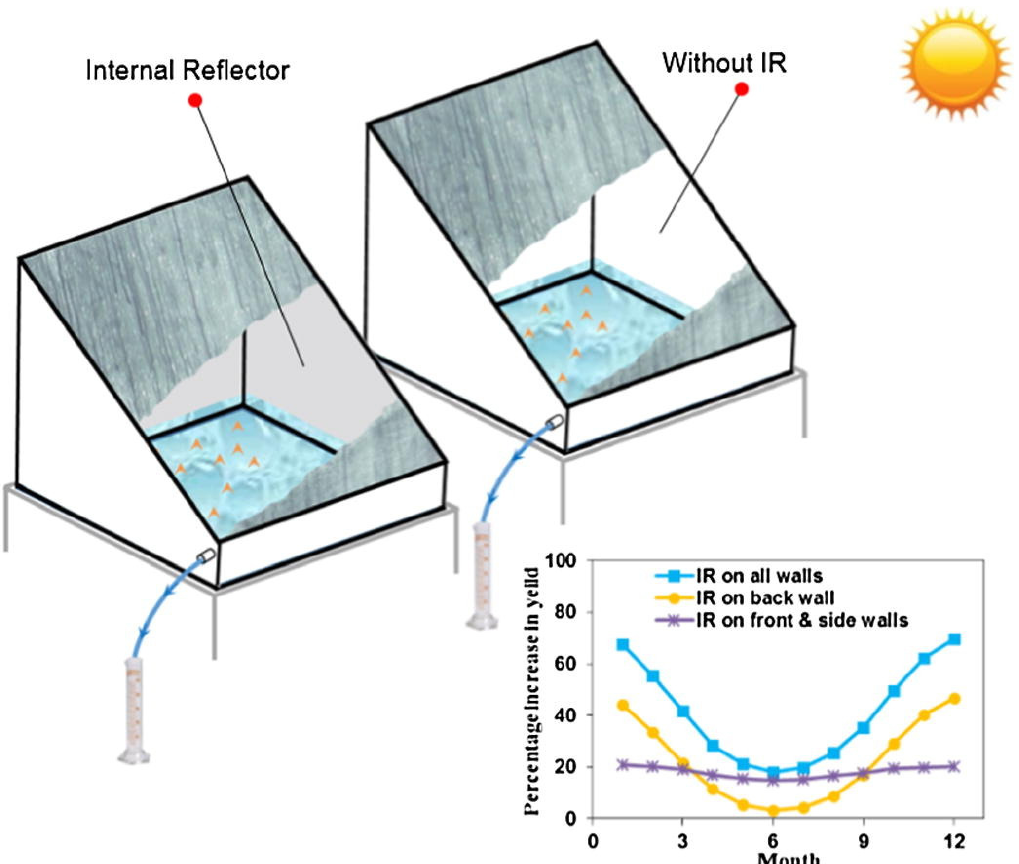
Figure 11. Test rig operation during daytime (adapted with permission from Reference [67], Copy- right 2016, Elsevier).